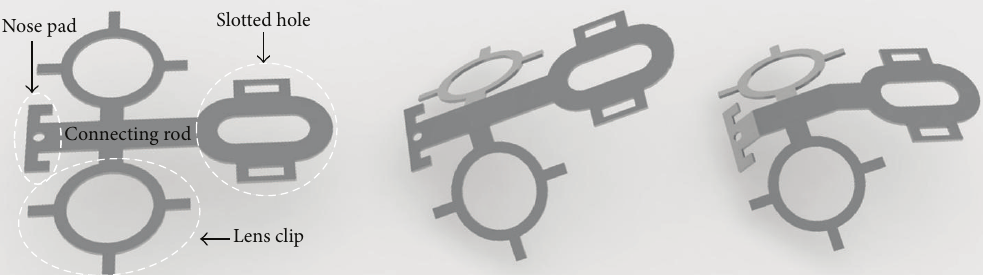
Figure 2: A schematic of the spectacle frame showing the functional components including the slotted hole, lens clip, nose pad, and connecting rod. And a brief visualization of the 3D shape is present.